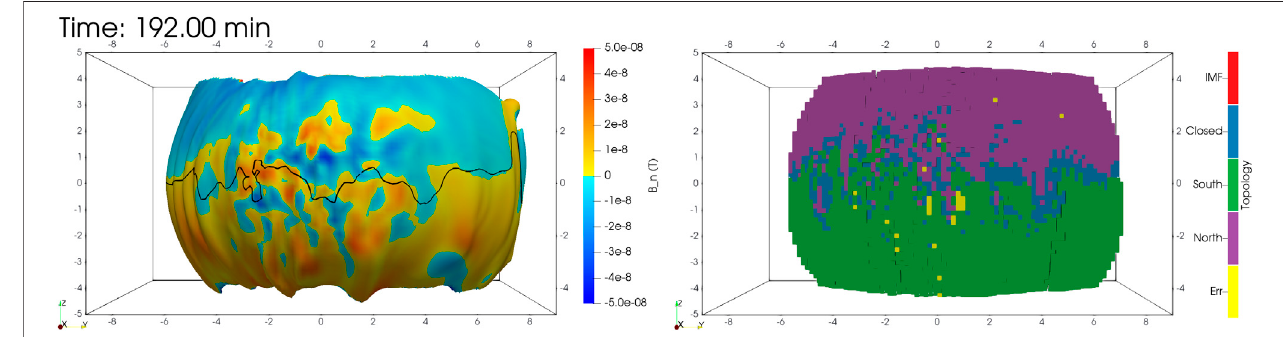
FIGURE7| Aviewofthemagnetopausefromthemagnetosheath,showingitsmagnetic fi eldproperties andplasmamotion,and potentialregionsofreconnection and plasma.Theleftpanel (A) showsthe B z (cid:2) 0contour,colouredbythemagnetic fi eldstrength normaltothesurface, B n .Theblacklinedenotesthe v z (cid:2) 0line:above the line, v z > 0, below v z < 0. The right panel (B) shows the magnetic topology of each simulation cell. IMF fi eld lines (red) have been fi ltered